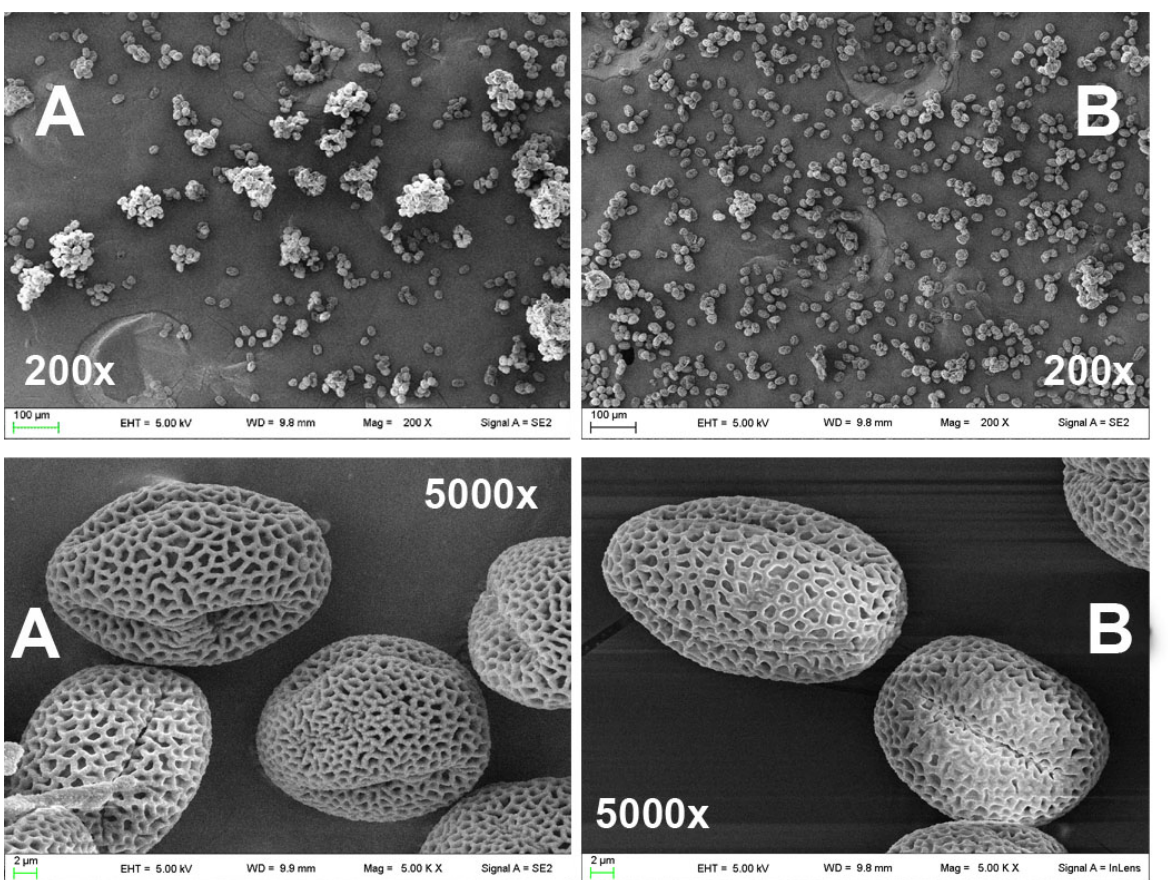
Figure 1. SEM images (200 × and 5000 × ) of olive pollen from control plants ( A ) and from Se-fertilized plants ( B